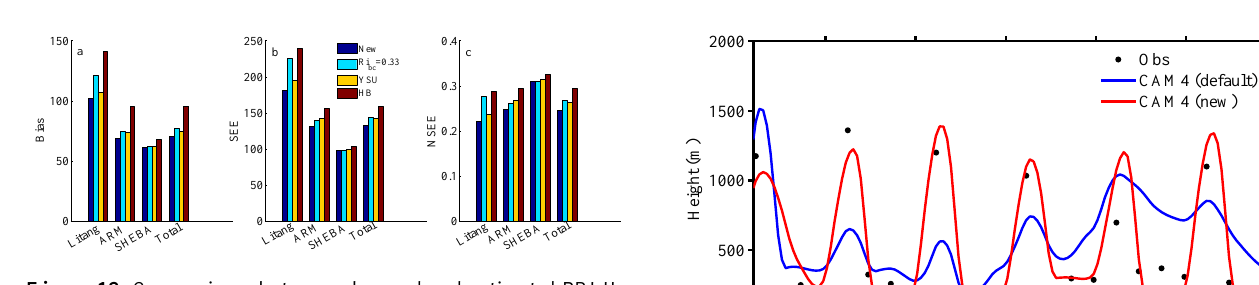
Figure 12. Comparisons between observed and estimated PBLHs with a single Ri bc = 0 . 33 for all PBL conditions, with Ri bc = 0 . 25 as in the YSU scheme, with Ri bc = 0 . 5 as in the HB scheme, and with the new, variable values ( Ri bc = 0 . 24, 0.31, and 0.39 for type I SBLs, type II SBLs, and UBLs, respectively): (a) bias, (b) standard error, (c) normalized standard error.